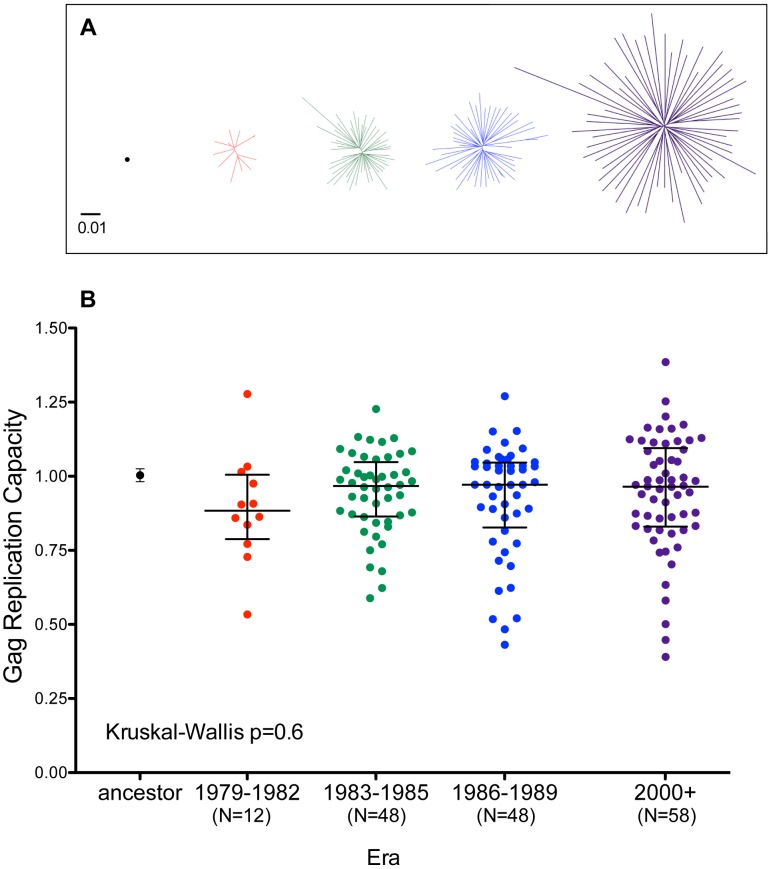
Replicative implications of Gag diversification during the North American Epidemic.
Panel A: Unrooted Maximum-Likelihood phylogenies, drawn on the same distance scale, depicting the inferred ancestor (single black dot), early-historic (red, 1979–1982), mid-historic (green, 1983–1985), late-historic (blue, 1986–1989) and modern (purple, 2000+) Gag clonal sequences from unique patients that were used to construct recombinant NL4-3 viruses for functional assessment. Panel B: NL4-3 normalized replication capacities of recombinant viruses containing the Gag sequence of the inferred ancestral sequence (Mean±S.E.M. of 3 replicate measurements) as well as patient-derived Gag clonal sequences (one per patient, representing the mean of ≥2 replicate measurements). An RC of 1 indicates replication equal to that of NL4-3 while RC>1 and <1 indicate RC higher or lower than NL4-3 respectively. Although visually there appears a trend towards lower replication capacity among Gag clones from early historic (1979–1982) era, there no significant differences in RC between any of the groups (Kruskal-Wallis test, p = 0.6).